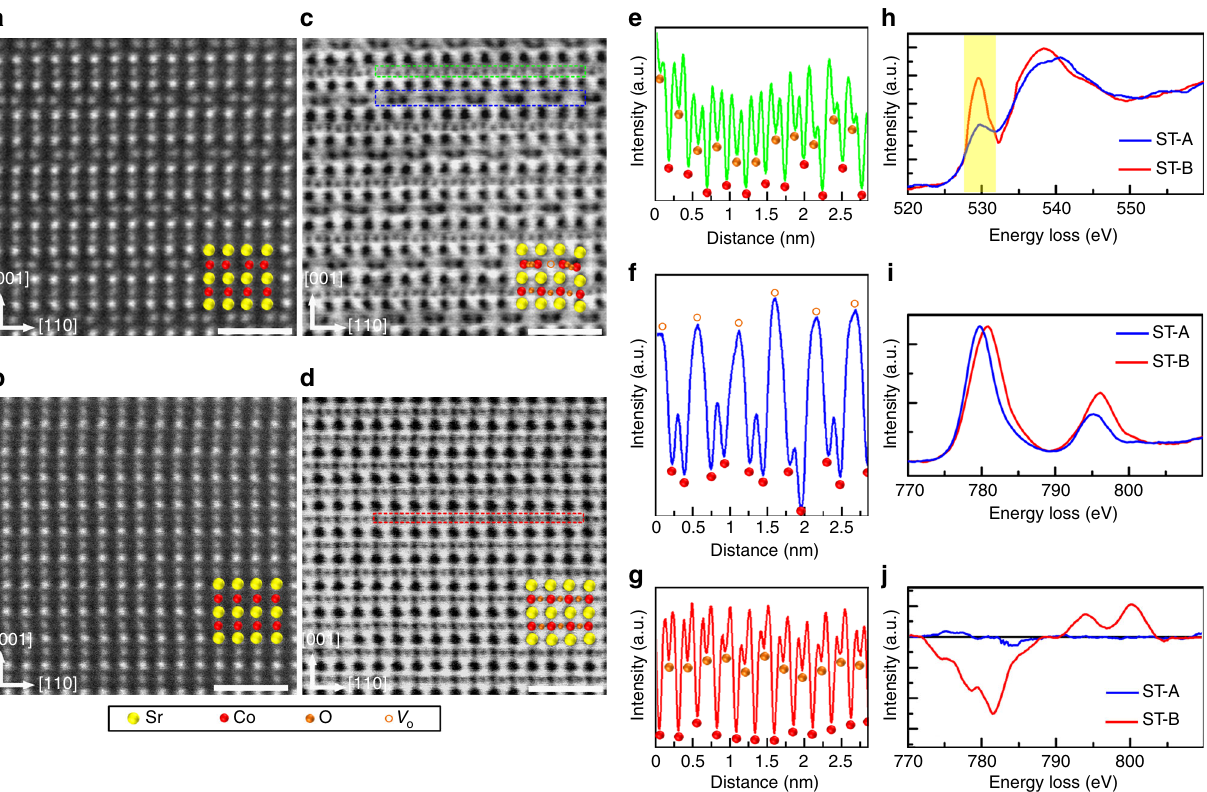
Fig. 4 Crystal and electronic structure of ex situ gated samples. STEM-HAADF images of a Sample ST-A and b Sample ST-B. STEM-ABF images of c Sample ST-A and d Sample ST-B, respectively. The higher the atomic number, the brighter (darker) the atom in HAADF (ABF). The white scale bars in a – d are 1 nm. Sr, Co, O, and V O sites are indicated by yellow, red, and orange spheres, and orange circles, respectively. Intensity line-scans of the ABF images of e CoO 2 and f CoO sublayers in Sample ST-A, and g CoO 2 sublayer in Sample ST-B. The line-scans correspond to the green, blue and red boxes as indicated in the ABF images, respectively. h O- K EELS; i Co- L EELS; and j Co-EMCD of Sample ST-A and -B. The pre-peak in the O K -edge is